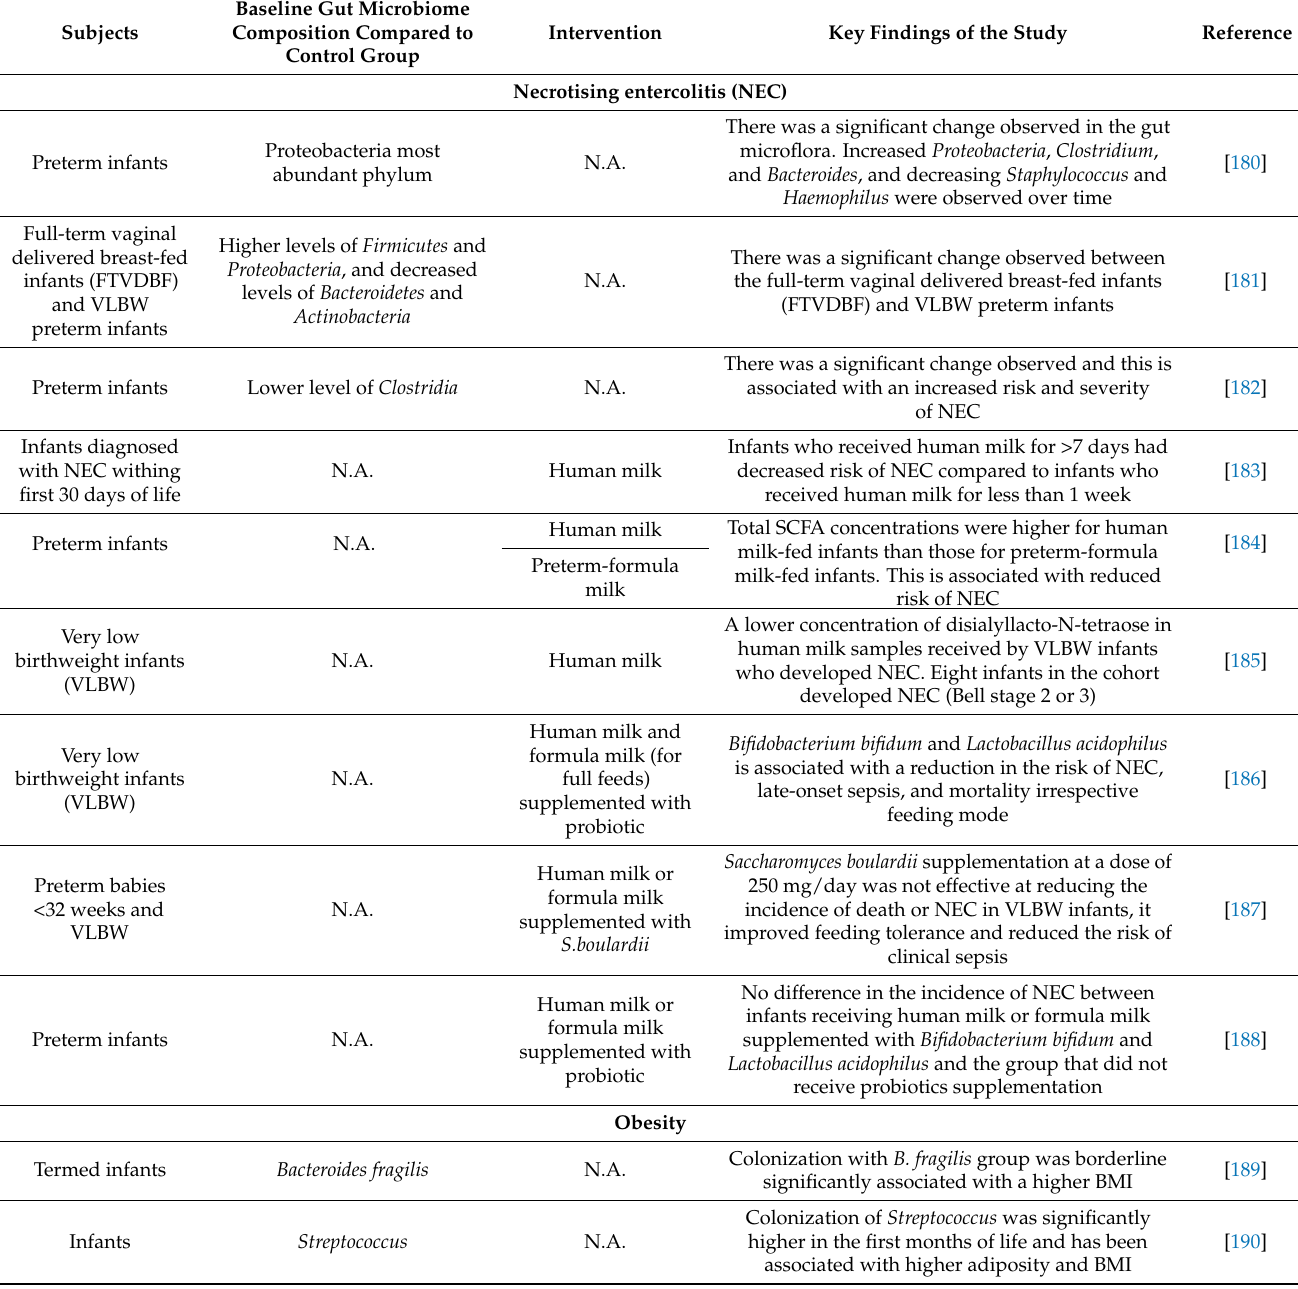
Table 2. Summary of early-life gut microbiome on health and